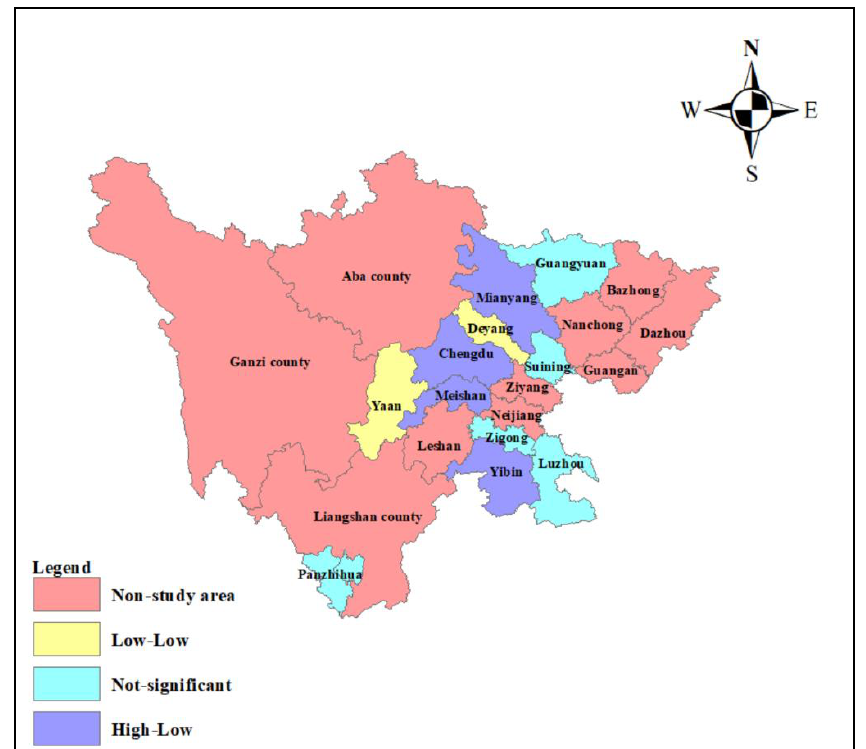
Figure 13. LISA aggregation diagram of the 11 counties’ CGLUE in 2015 .